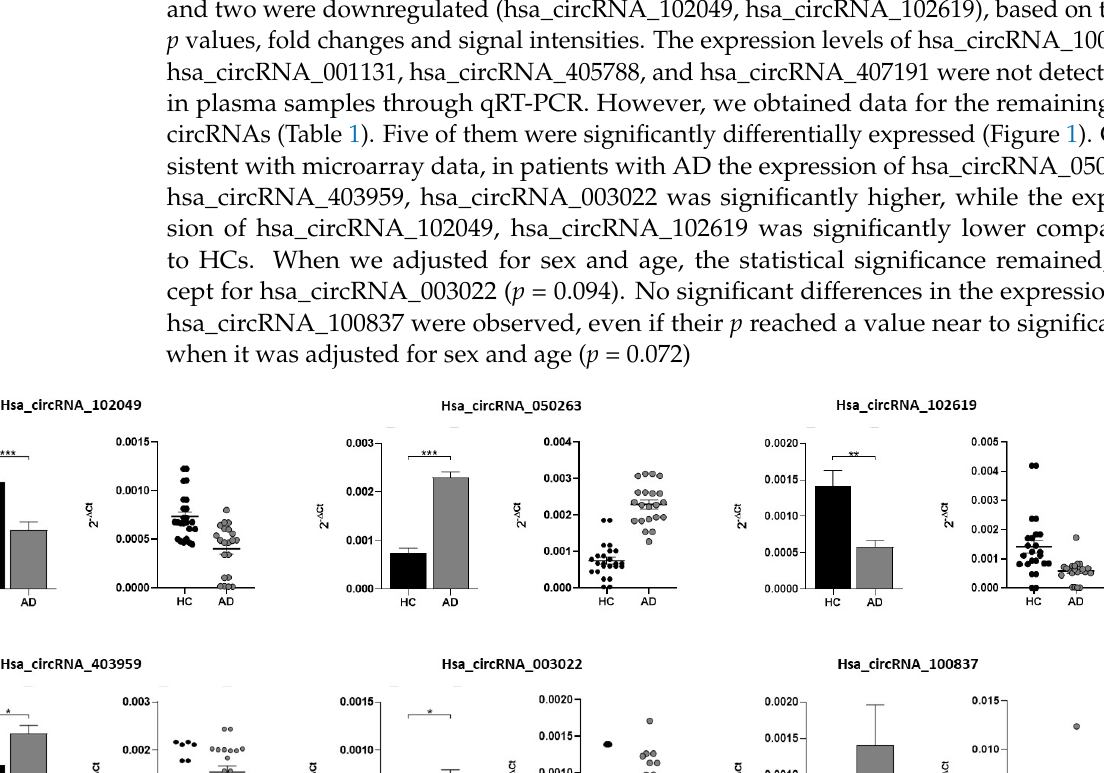
Figure 2. Graphic representation of circRNA expression levels in males and females in subjects with HC and AD. * p < 0.05, ** p < 0.01, *** p < 0.001. In the validation study, we added a small population of subjects with MCI, and we found upregulated levels similar to AD for hsa_circRNA_050263, hsa_circRNA_403959, hsa_circRNA_003022 relative to HCs (Figure 3). When we adjusted for sex and age, the statistical significance remained, and for circRNA_100837 the p reached a value near significance ( p = 0.055). Table 3 summarizes the circRNAs results of the validation study.